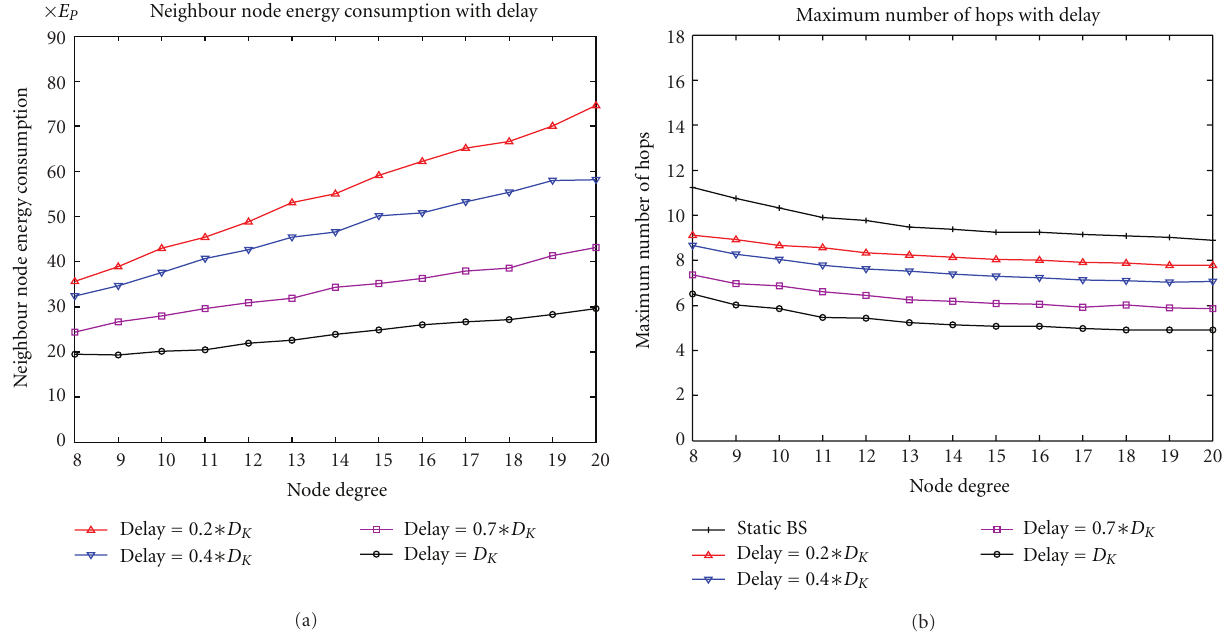
Figure 11: (a) The minimum cluster head neighbouring sensor nodes energy consumption as the node degree is varied, for various data gathering delay. (b) The maximum number of hops as it varies with the node degree, for static and mobile BSs.